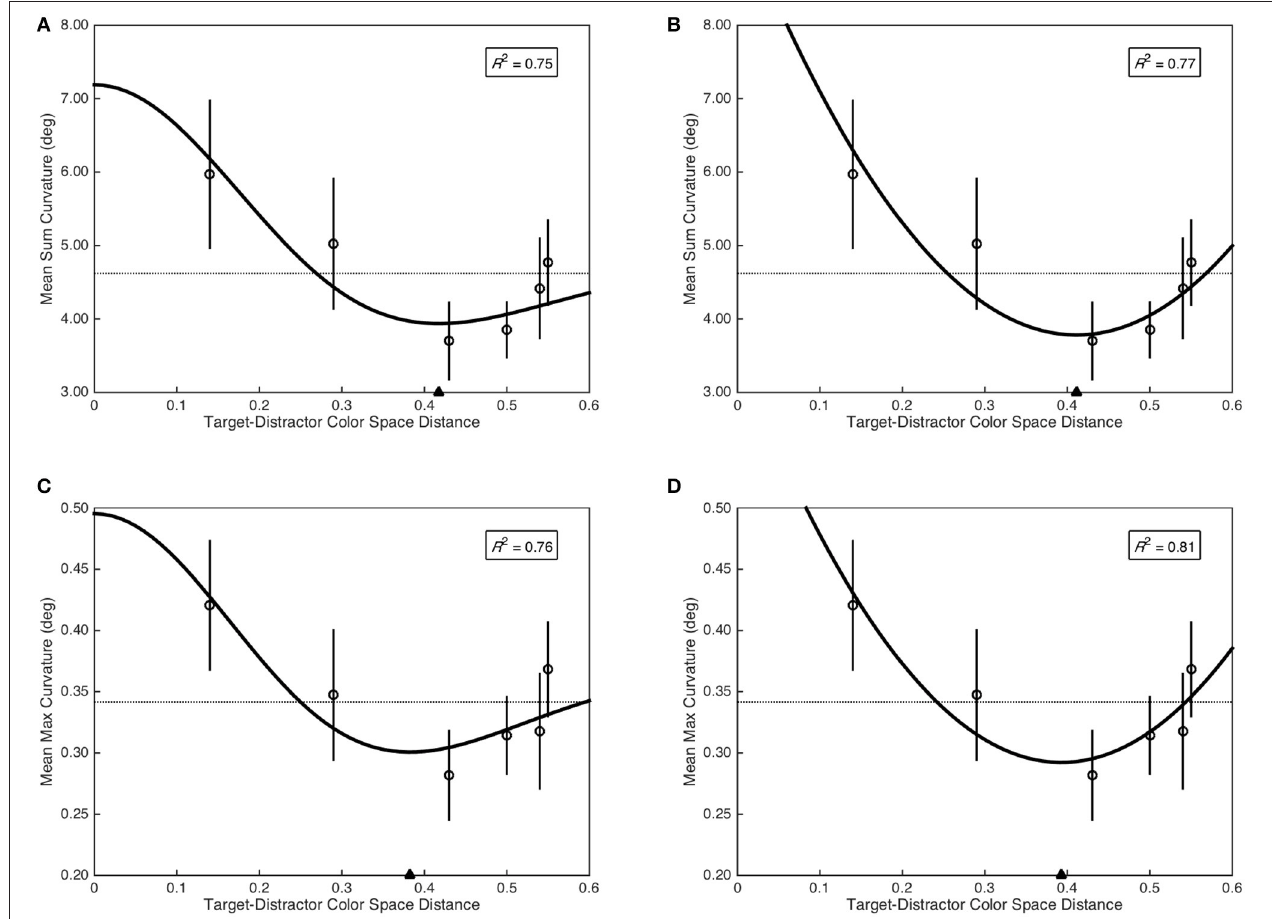
FIGURE 4 | Saccade curvature as a function of target-distractor color space distance. Open circles represent mean saccade curvature and error bars represent standard error. Dashed horizontal lines indicate the grand mean across all color space distances. Filled triangle on the abscissa indicates the minima of the fitted models. The coefficient of determination is included in the top right of each plot. (A) Mean sum curvature fit as a function of the Mexican hat model. (B) Mean sum curvature fit as a function of the quadratic model. (C) Mean max curvature fit as a function of the Mexican hat model. (D) Mean max curvature fit as a function of the quadratic